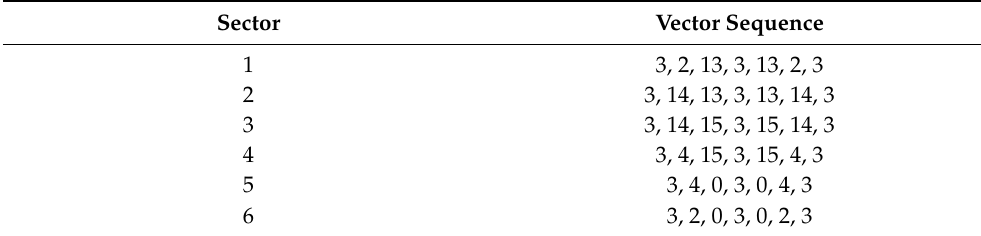
Table A4. Vector switching sequences of the third outer hexagon, by the ith designation (V i